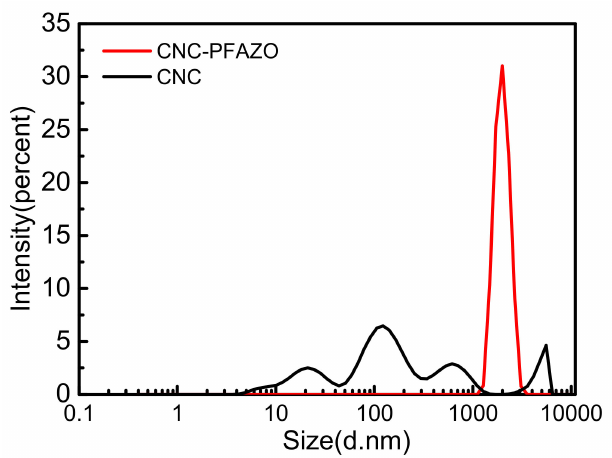
Figure 7. The hydrodynamic diameter of the CNC and the CNC-PFAZO by intensity.